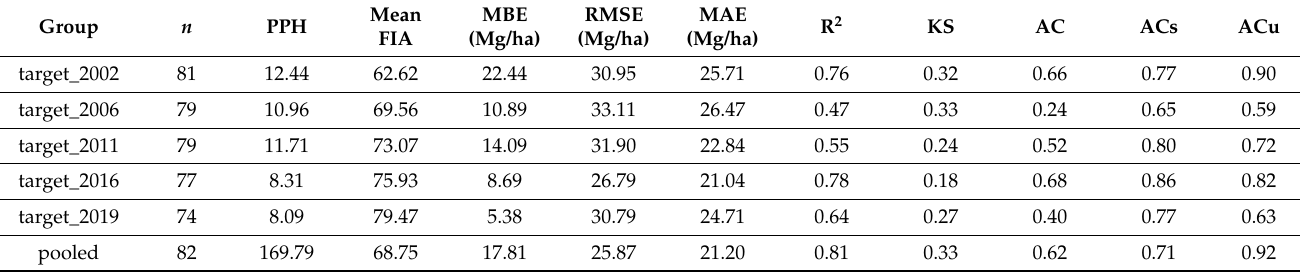
Table 5. Agreement statistics (SI-corrected)—216,500 Ha